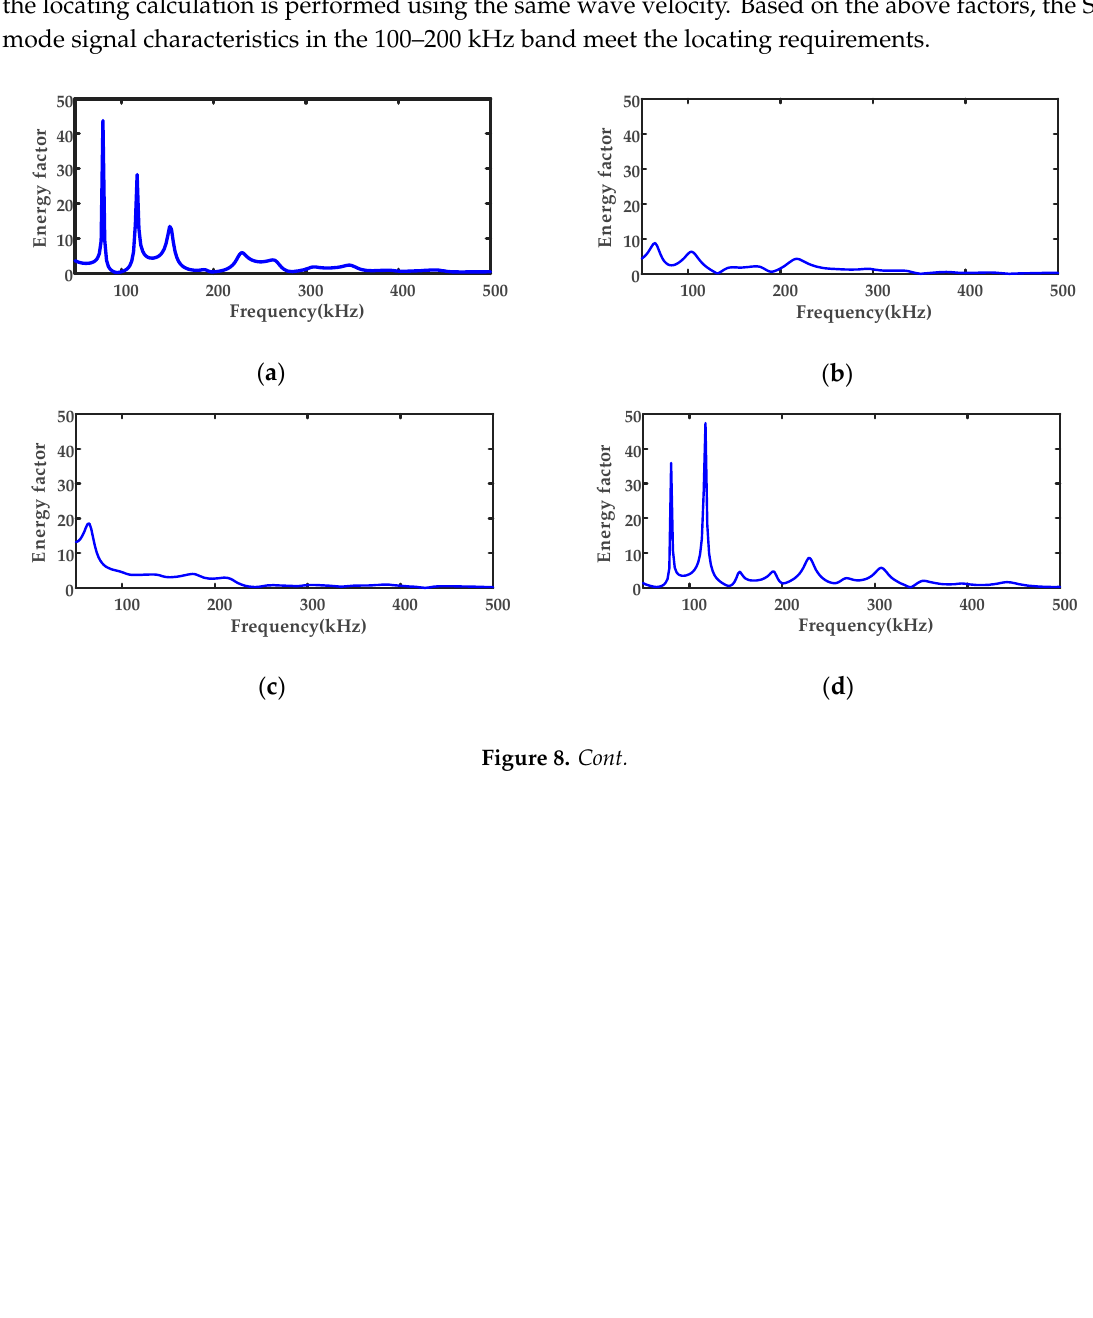
Figure 8. Energy factor curves: ( a ) point 1; ( b ) point 2; ( c ) point 3; ( d ) point 4; ( e ) point 5; ( f ) point 6; ( g ) point 7. 4. Experiments of Impact Source Localization in Stiffened Panel 4.1. Impact Signal Generation and Wave Velocity Measurement In the impact source locating experiment, the impact source needed to meet the following requirements: the impact source energy must be stable with good repeatability; the impact point position must be precisely controllable; the personnel safety must be ensured. In this paper, a steel projectile is launched by a launcher. The diameter of the projectile was 7.5 mm and the weight was 1.73 g. The initial velocity of the projectile is shown in Table 2. The average velocity was 21.0 m/s. Table 2. Steel projectile initial velocity. Number of